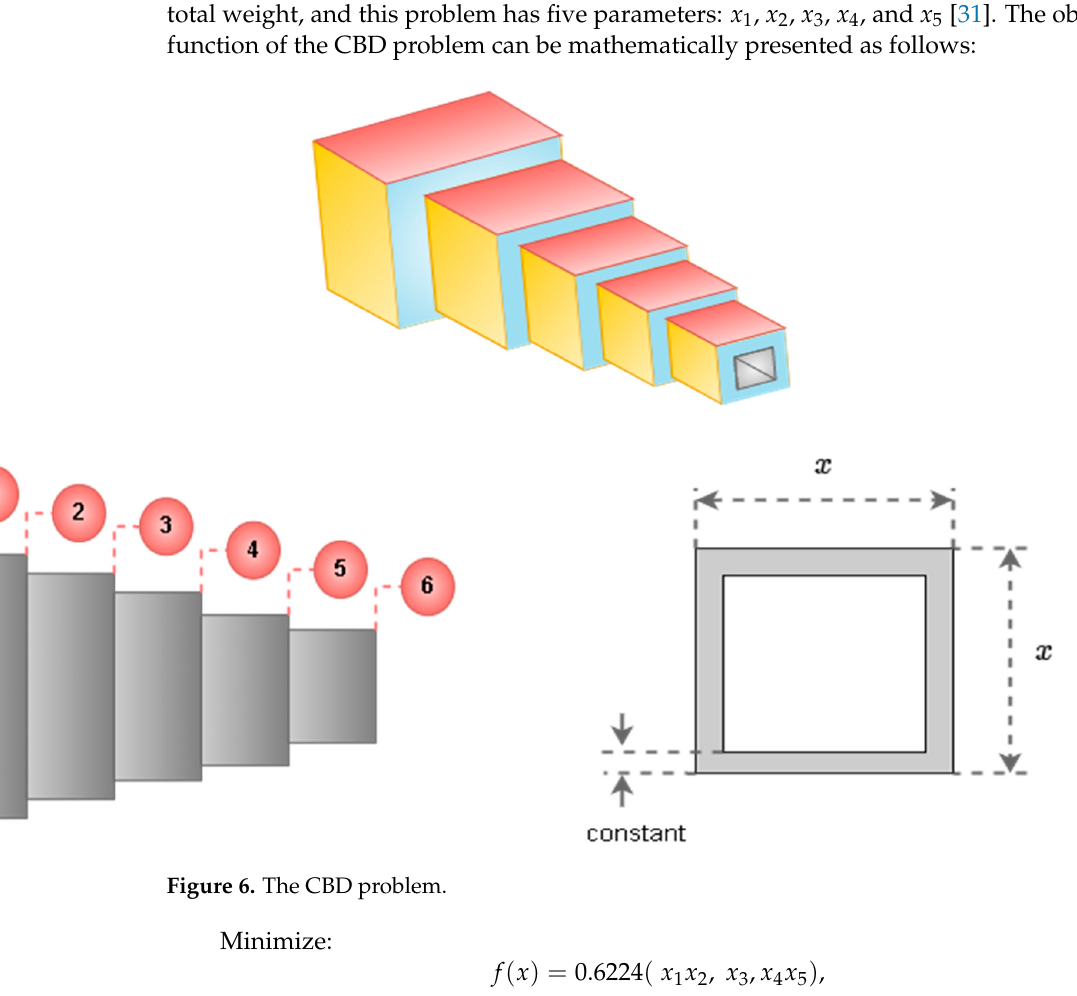
Table 8. Results of RSA ‐ SO and other methods for solving the CBD problem. Method